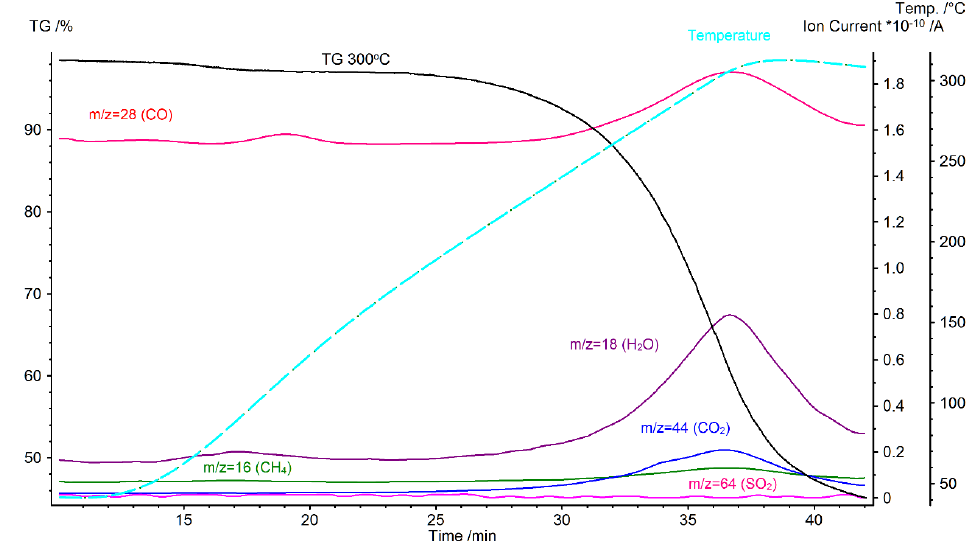
Figure A10. TG curve and ion current curves for the oat straw torrefaction process carried out up to 300 °C.